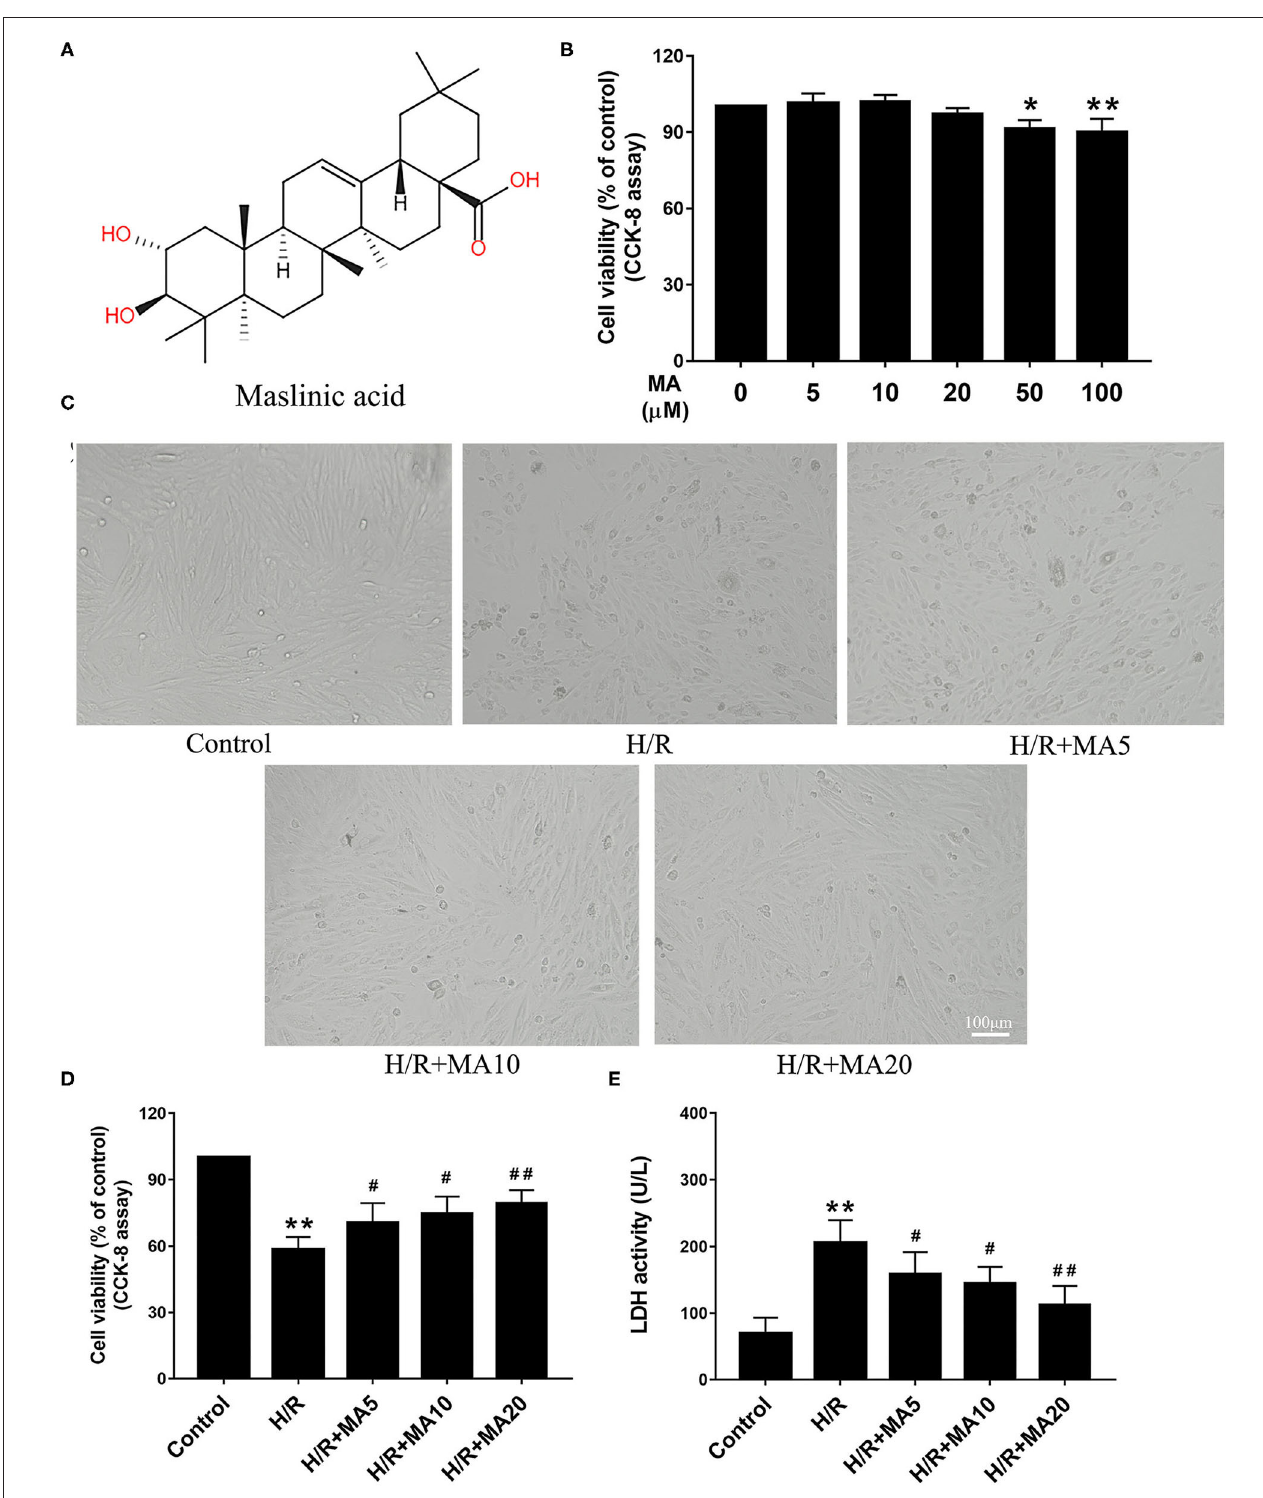
FIGURE 1 | The effects of maslinic acid (MA) on hypoxia/reoxygenation (H/R)-induced cardiomyocyte injury. (A) Chemical structure of MA. (B) The cytotoxicity effects of MA on the H9c2 cells were tested by the Cell Counting Kit-8 (CCK-8). (C) After pretreating with indicated concentrations of MA (5, 10, and 20 µ M) and being subjected to H/R procedure, the morphology of H9c2 cells were detected by a light microscope. (D,E) The H9c2 cells injury were measured d by CCK-8 assay and lactate dehydrogenase (LDH) release assay. All the values are representative of at least three independent experiments and expressed as the mean ± SD. * P < 0.05 and ** P < 0.01 vs. control group; # P < 0.05 and ## P < 0.01 vs. H/R group.